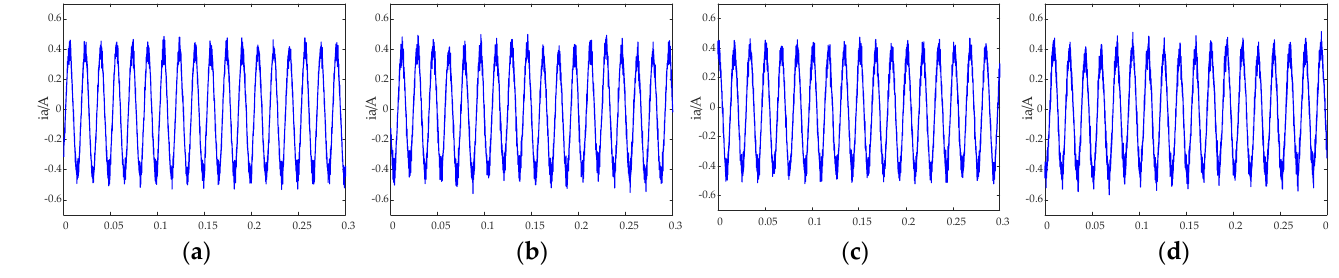
Figure 15. Experimental results of output phase current at m = 0.909: ( a ) strategy A; ( b ) strategy B; ( c ) strategy C; ( d ) strategy D.